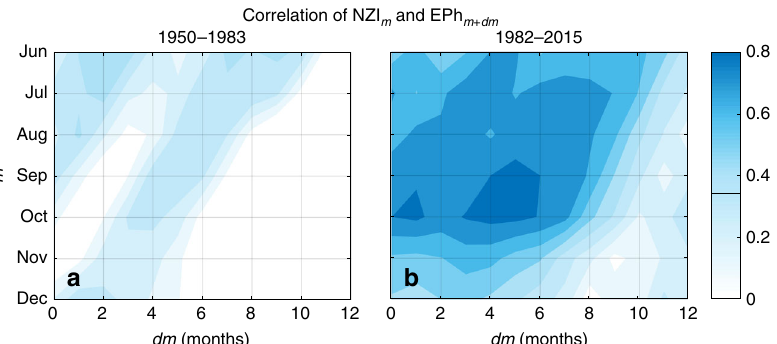
Fig. 7 Interhemispheric teleconnections between NZI and SST anomalies in the northwestern Paci fi c have signi fi cantly strengthened during the last three to four decades. a Time-lagged correlation between NZI (averaged over the month indicated in the vertical axis) and SST in the region east of the Philippines (EPh) (box in 5 – 15°N and 130 – 150°E; lagged forward in time as indicated in the horizontal axis) in 1950 – 1983. Solid black line on the colorbar indicates the threshold below which correlations are statistically insigni fi cant ( α = 0.05 signi fi cance level); b Same as ( a ), but for the period 1982 –